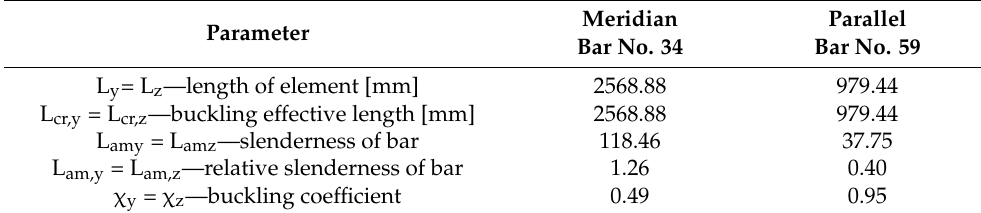
Table 5. Buckling Table 5. Buckling parameters.